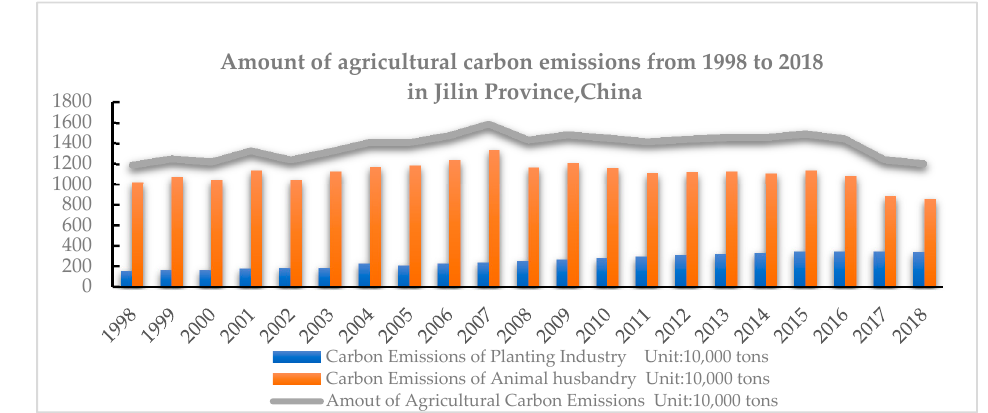
Figure 1. Amount of agricultural carbon emissions from 1998 to 2018 in Jilin Province, China.